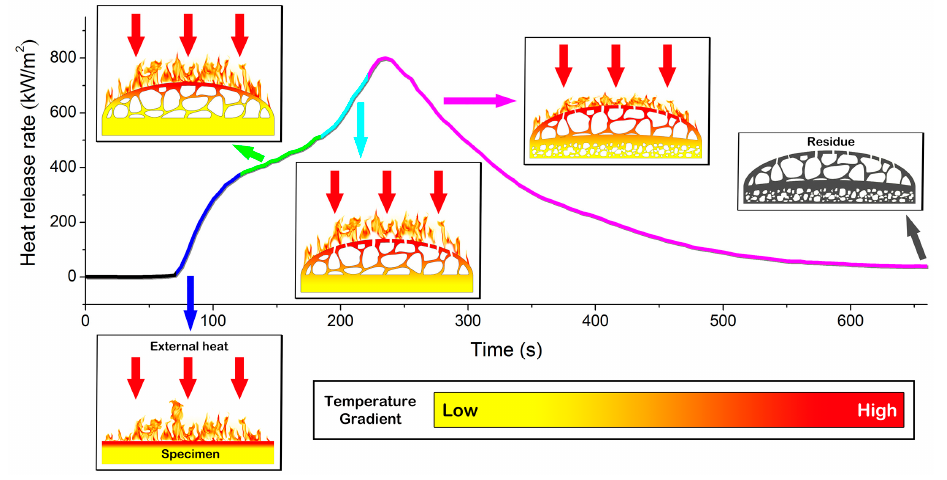
Figure 12. Formation mechanism of the unique char.